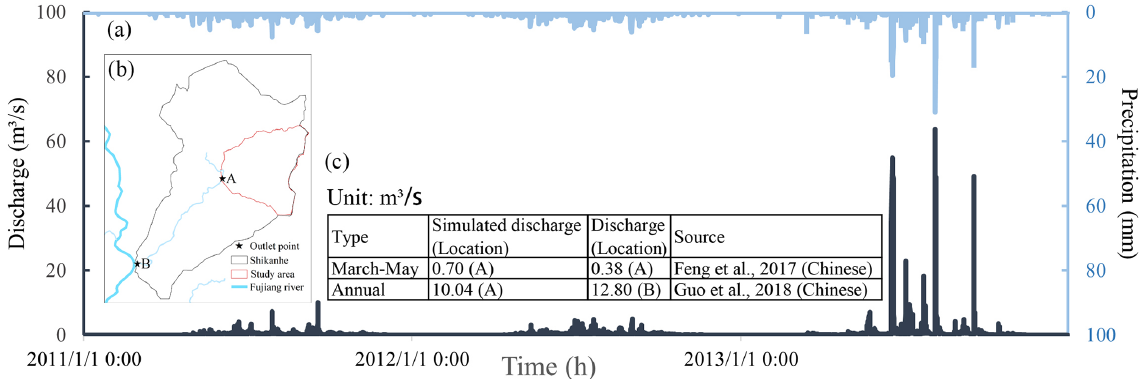
Figure 4. The input and output of the hydrograph. (a) The input hourly precipitation and simulated discharge in 2011–2013 in Scenario PP, (b) the locations of the specified outlet points and (c) a comparison of the simulated average discharge to the recorded discharge.